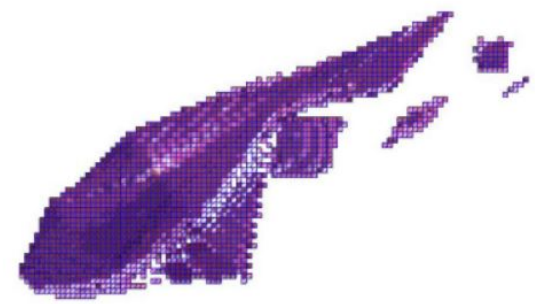
Figure 6: Model of sulfur ore